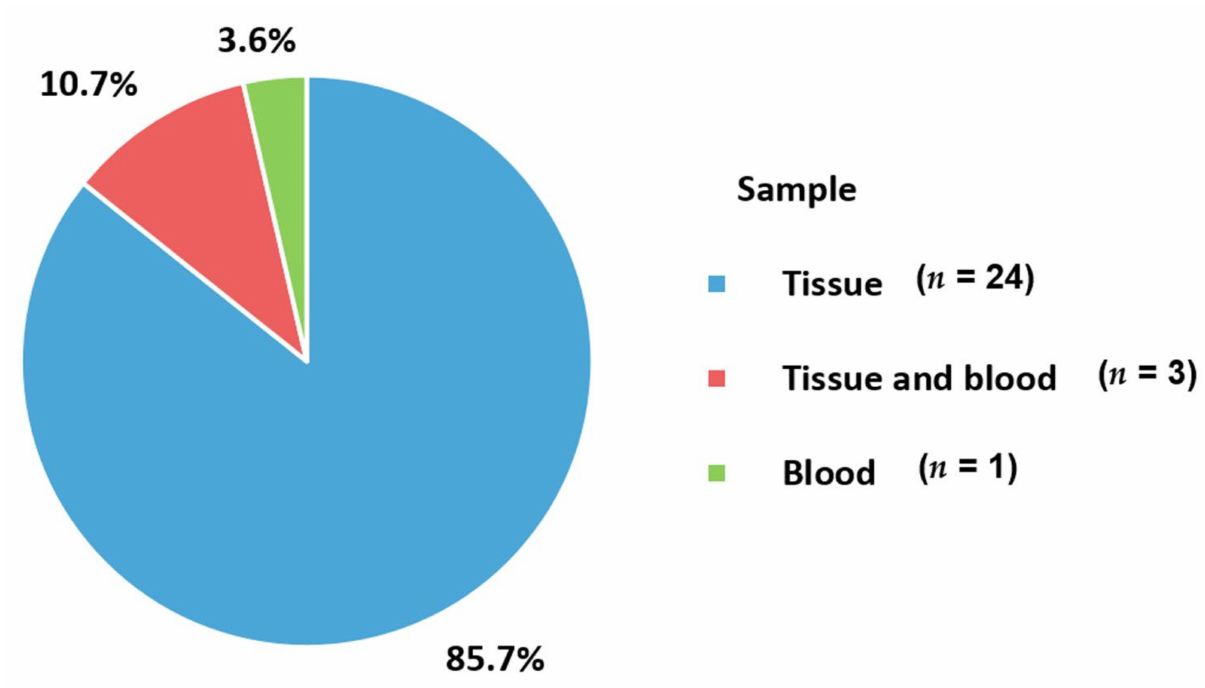
Figure 1. Sample type for identifying PD-1